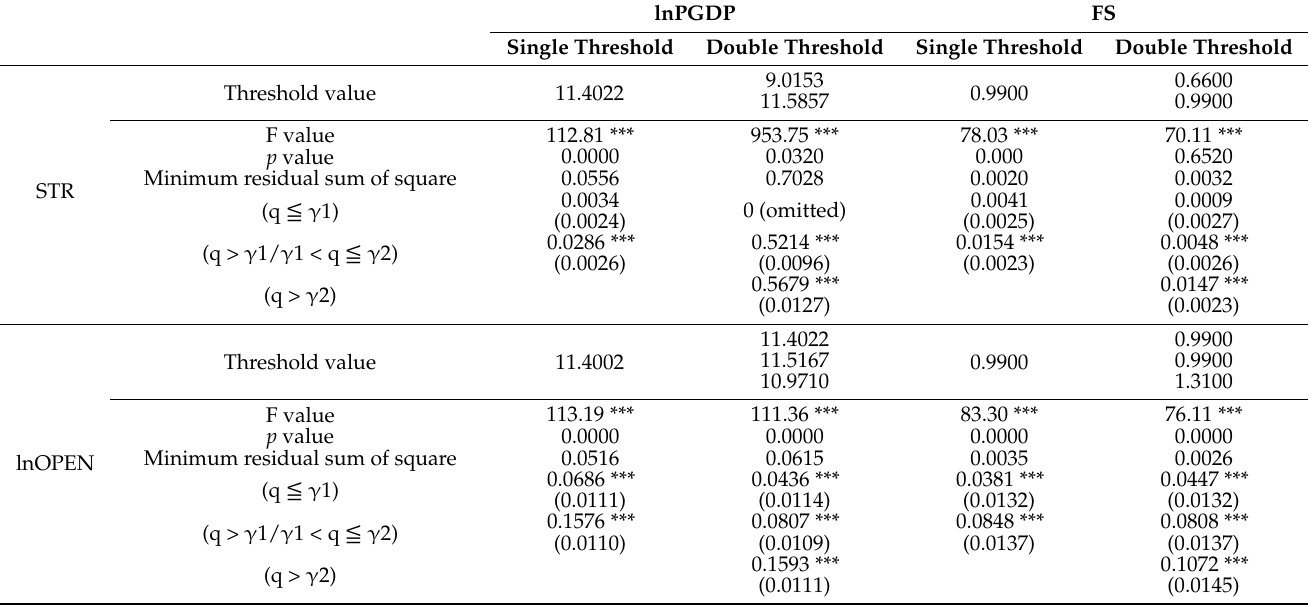
Table 5. Threshold effect regression.